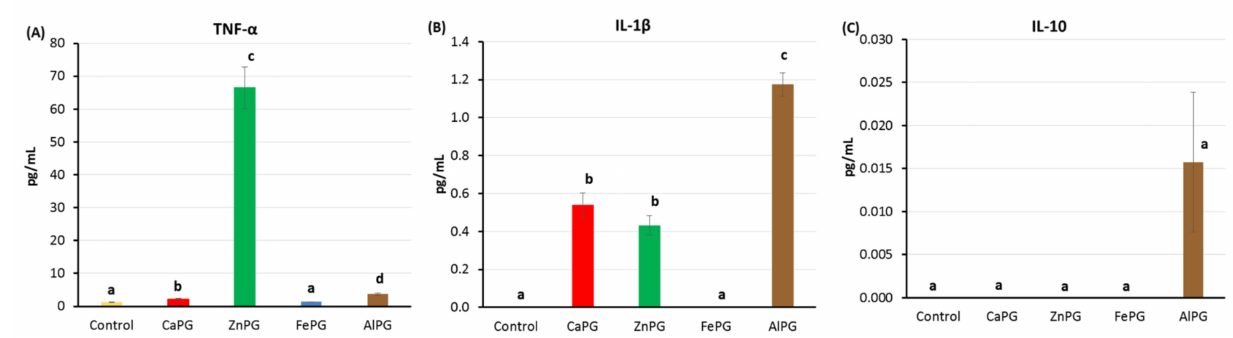
Figure 7. Effect of CaPG, ZnPG, FePG, and AlPG beads on tumor necrosis factor- α (TNF- α , ( A )), interleukin-1 β (IL-1 β , ( B )), and interleukin-10 (IL-10, ( C )) production by non-stimulated human peripheral blood mononuclear cells (hPBMCs). Different letters indicate significant differences between pectin gel beads prepared with different cations ( p < 0.05).